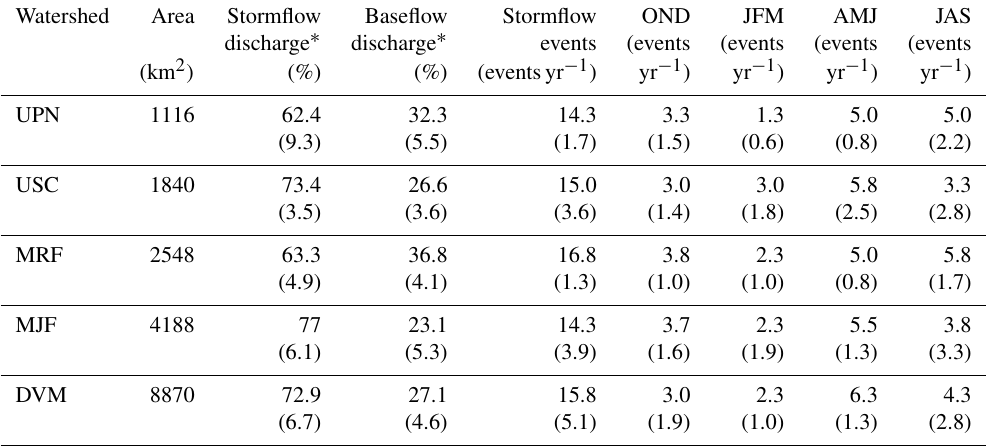
Table 1. Watershed hydrologic